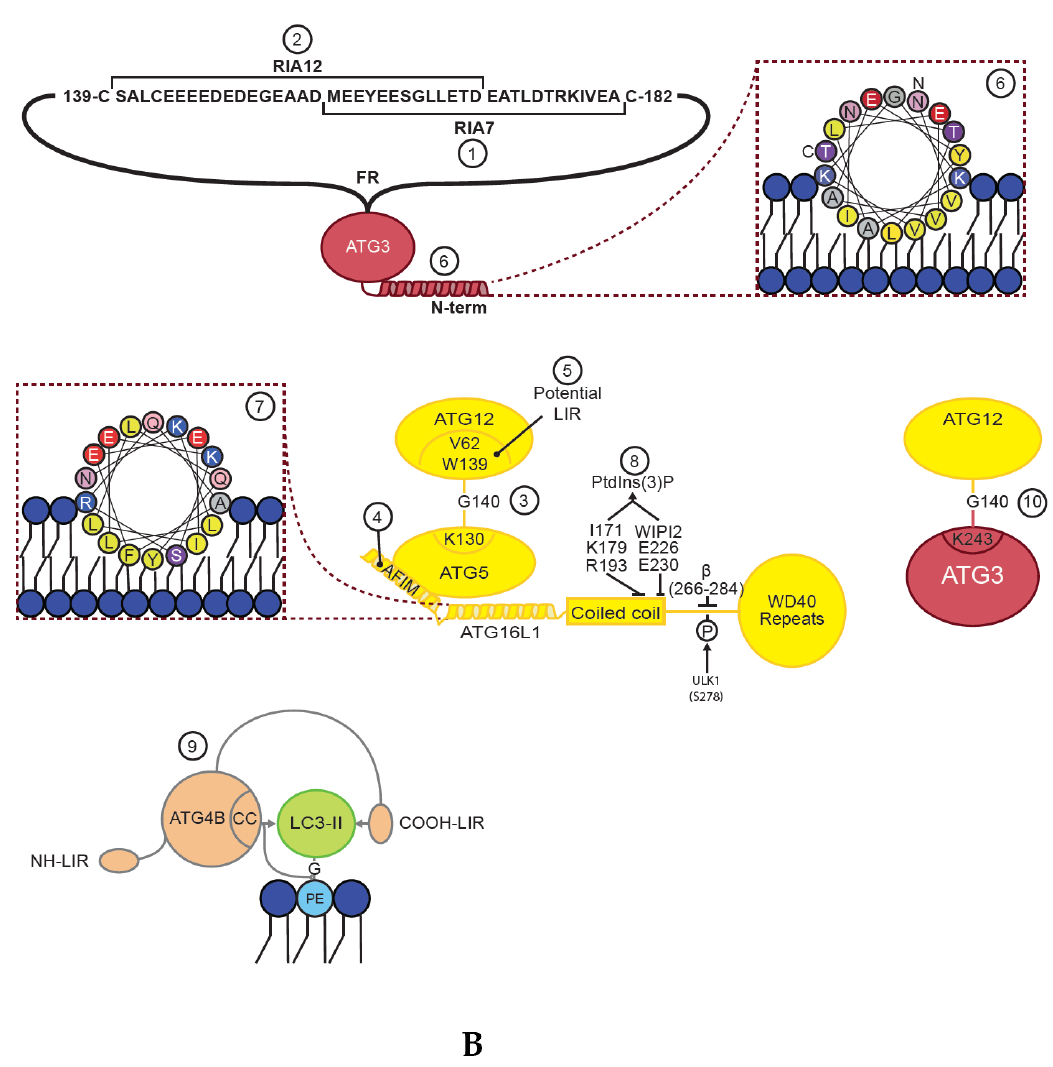
Figure 2. ( A ) Mechanisms and interactions (protein and membrane) of core autophagy components required for priming, lipidation and de-lipidation of ATG8 proteins during starvation-induced autophagy are illustrated. The illustration also includes the conjugation of ATG12 to ATG5 as well as the less commonly reported conjugation of ATG12 to ATG3 (shaded), which serves its purpose outside of autophagy. Key interactions are numbered and shown in greater detail in ( B ). ( B ) ATG3 interacts with ATG7 and ATG12 through motifs located in a flexible region (aa 88–192), these motifs are referred to as RIA7 (1) and RIA12 (2) respectively. An amphipathic helix in the very N-terminal end of ATG3 (aa 1–26) provides membrane binding essential for lipidation of ATG8 proteins (6). G140 of ATG12 is conjugated to K130 of ATG5 (3) or K243 of ATG3 (10). It is proposed that V62 and W139 of ATG12 (5) serves as a LIR motif to secure the complex to the membrane of an autophagosome during lipidation. ATG16L1 interacts with ATG5 through its N-terminal helix (aa 13–28) (4). Membrane interaction of ATG16L1 is achieved through multiple interactions; an amphipathic helix near the N-terminal end provide membrane binding and is required for ATG8 lipidation (7), conserved residues in the coiled-coil domain together with its interaction with the phosphatidylinositol 3-phosphate (PtdIns(3)P) e ff ector protein WIPI2 (8) provide binding to PtdIns(3)P and membrane binding through the β -isoform specific insert is important for ATG8 protein lipidation to damaged endosomes / lysosomes. The β -isoform specific insert is a highly post-translationally modified area in ATG16L1 and includes a confirmed phosphorylation site for ULK1 on S278. ATG4B interacts with ATG8 proteins through its catalytic core (CC) and an N-terminal and a C-terminal LC3-interacting region (LIR)